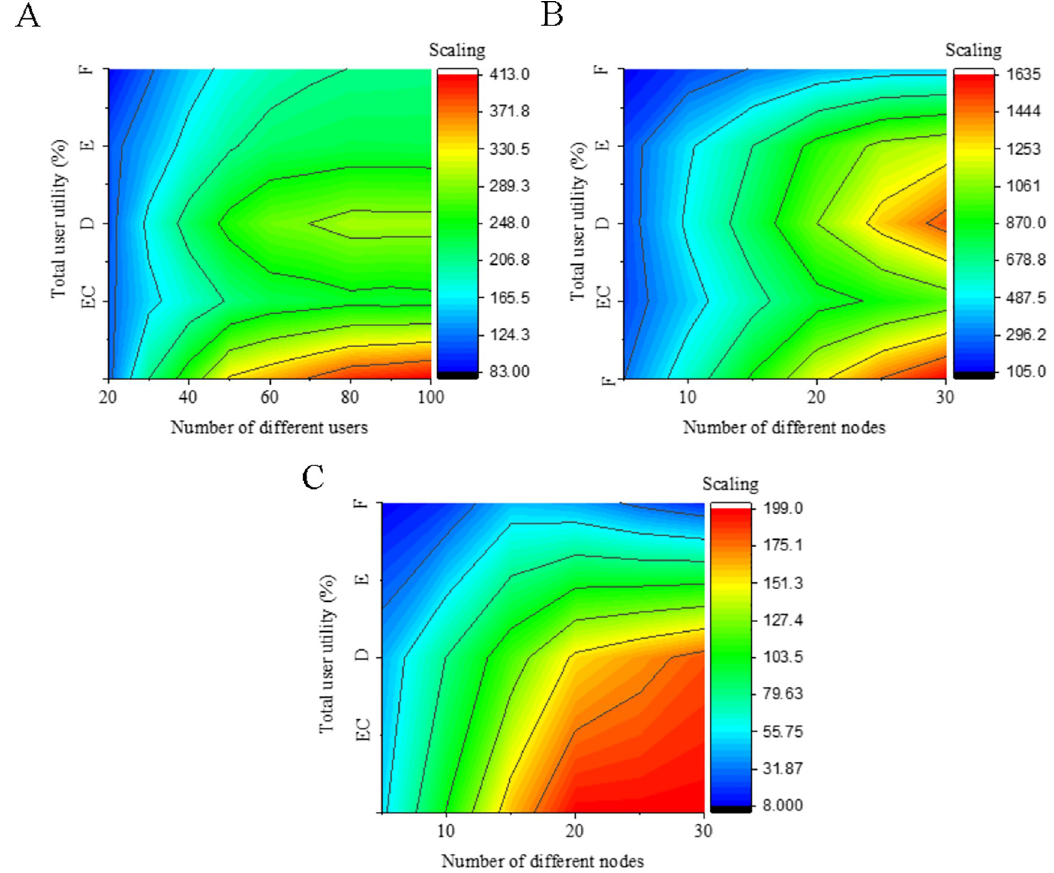
Fig 10. Comparative analysis results of different